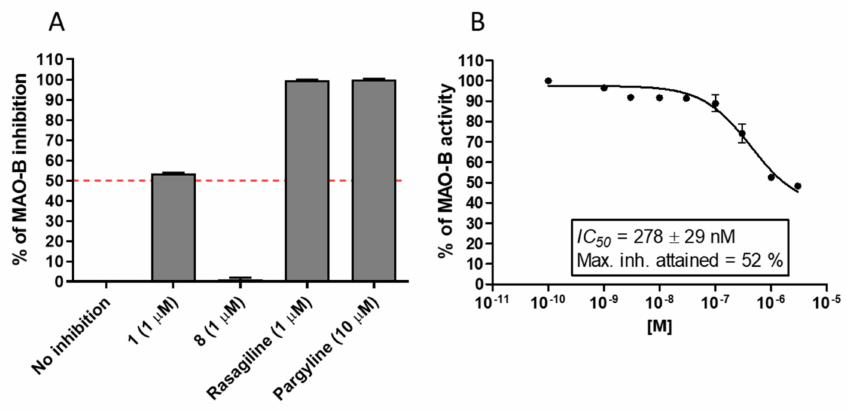
Figure 4. ( A ) Inhibition of MAO-B – screening of tested compounds and the reference inhibitors (rasagiline IC 50 = 25 nM, pargyline IC 50 = 652 nM); ( B ) Dose-dependent curve of compound 1